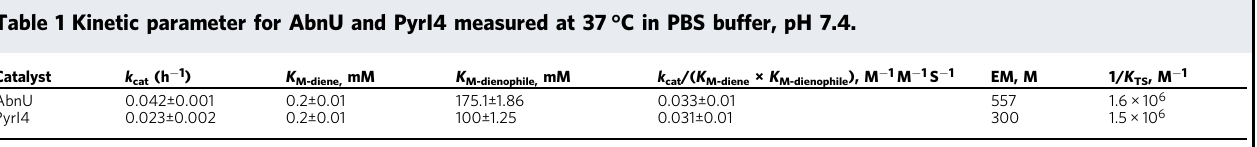
The estimated errors re fl ect the SD of three independent measurements. Under similar conditions, k uncat is 0.075×10 − 4 M − 1 h − 1 . EM represents effective molarity ( k cat / k uncat ) 34 . Chemical pro fi ciency (1/ K TS = k cat /K M-diene × K M-dienophile )/ k uncat ) 35